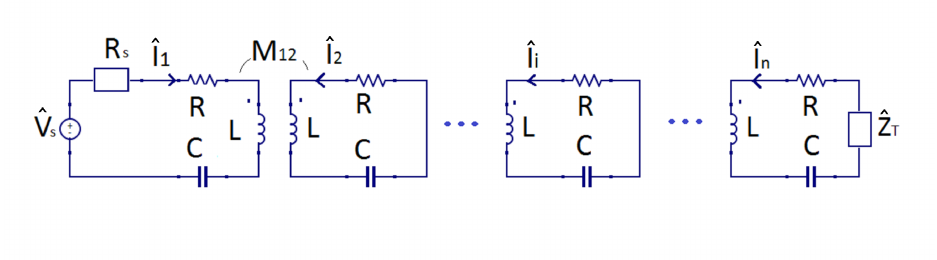
Figure 2. Equivalent circuit of a system composed of n resonator cells with optional termination impedance in the last